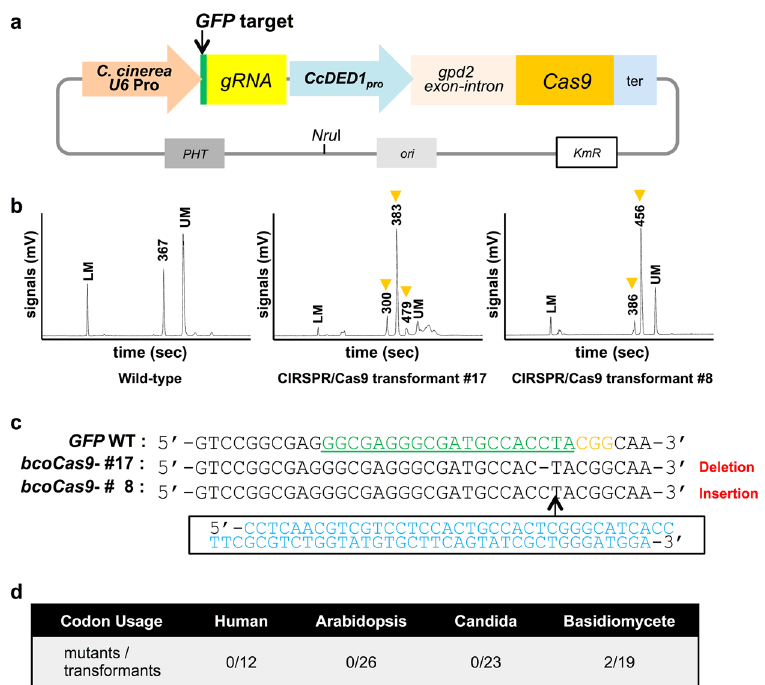
Figure 3. Construction of a CRISPR/Cas9 system in C. cinerea . ( a ) The CRISPR/Cas9 vector for C. cinerea genome editing. Four types of codon-optimized Cas9 were tested. An NruI site was used for linearization. ( b ) Capillary gel electrophoresis of the PCR products of CRISPR/Cas9 transformants #17 and #8. Arrowheads show peaks not detected in wild-type. LM; lower marker, UM; upper marker. ( c ) Sequences obtained by direct sequencing of PCR products from the two CRISPR/Cas9 transformants. The target sequence of gRNA (green) and PAM sequence (yellow) are indicated. The 75-bp insertion in the line #8 is in blue. ( d ) Comparison of the mutation rates of four types of codon optimization in the transformants as detected by capillary gel electrophoresis